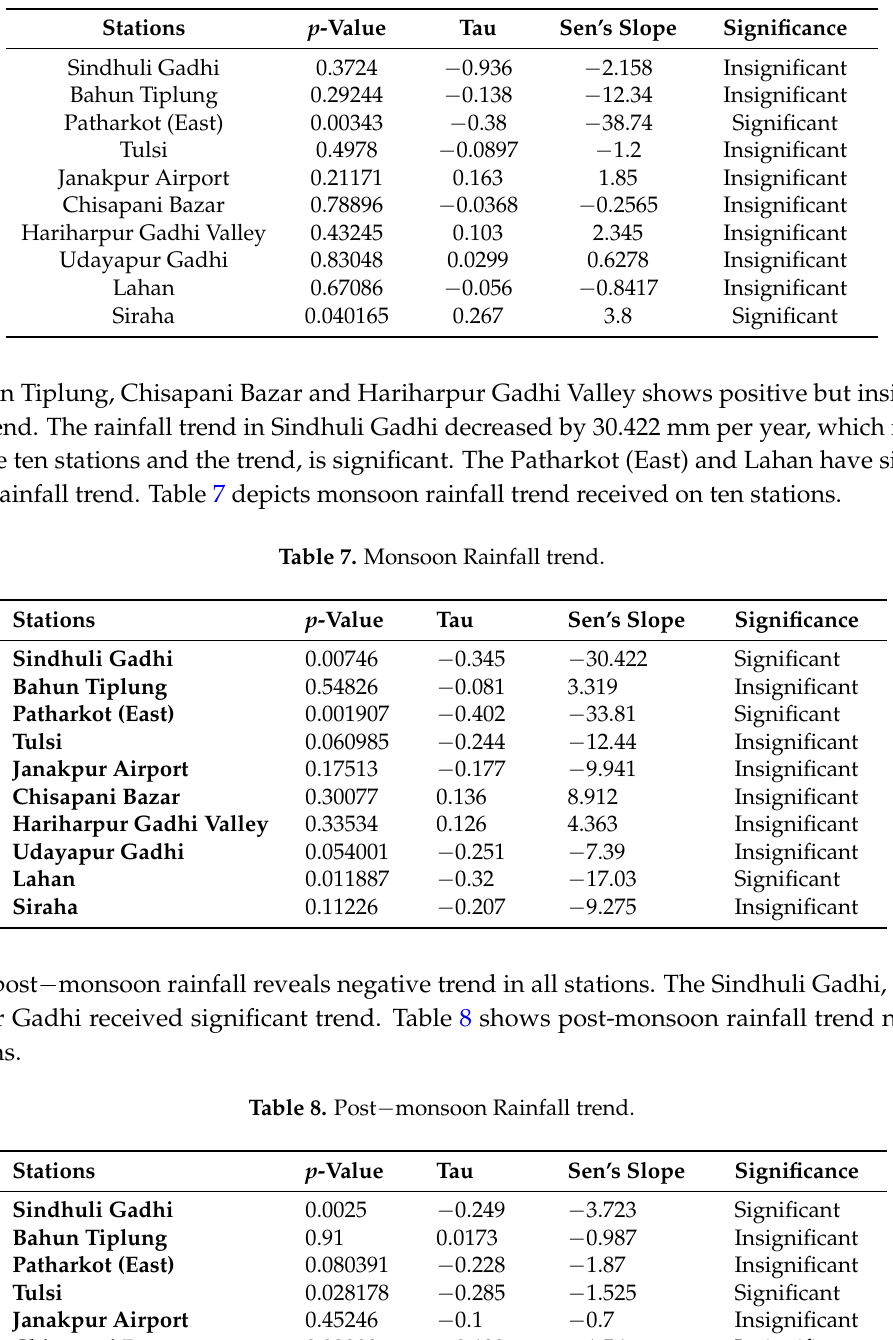
Table 6. Pre − monsoon Rainfall trend.